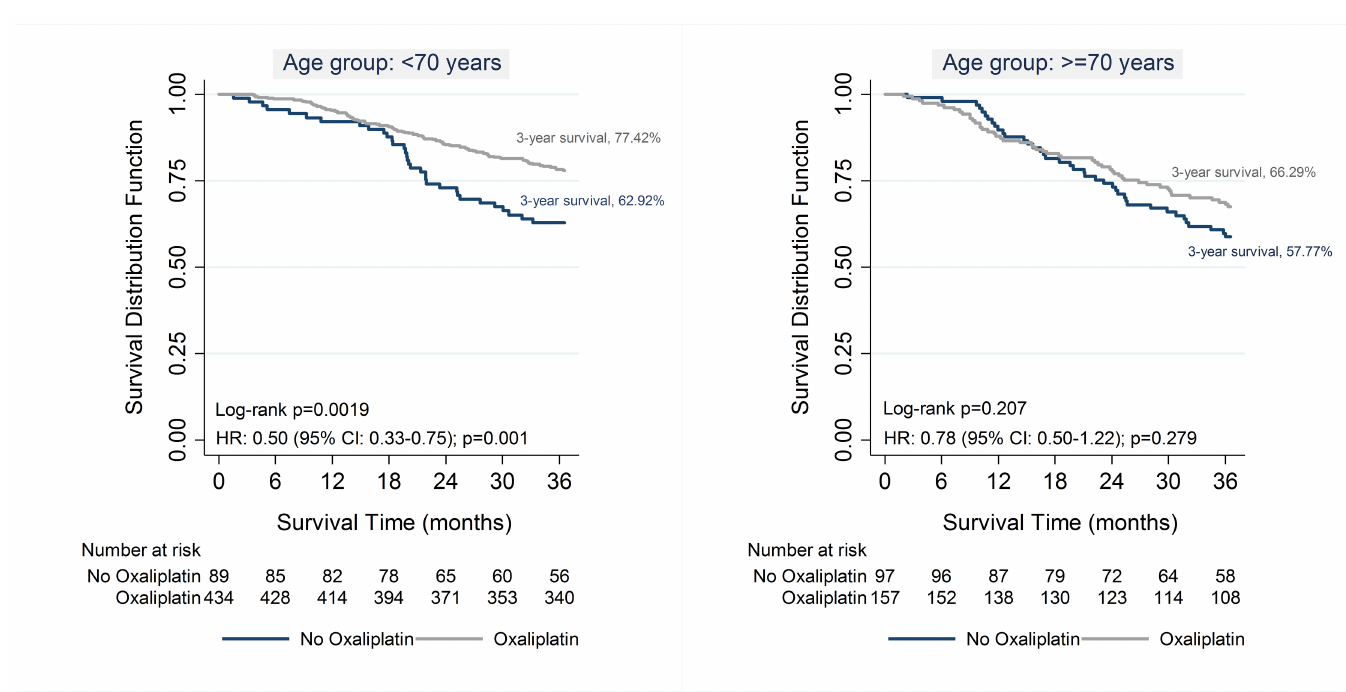
Fig 2. Three-year overall survival according to the Receipt of oxaliplatin among patients receiving ACT by age group ( < 70 years and (cid:21) 70 years).